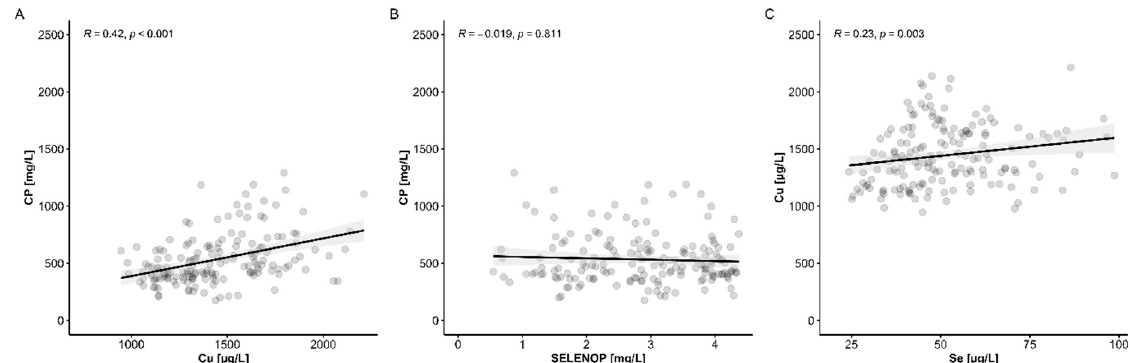
Figure 1. Analysis of serum Cu status in COVID-19 in relation to serum Se status. ( A ) The two biomarkers of Cu status, i.e., total Cu and CP concentrations showed a significant positive correlation in the full collection of serum samples. ( B ) In comparison, there was no interrelation of serum CP with SELENOP, whereas ( C ) serum Cu and Se showed a significant positive correlation with a marginal slope. R : Spearman correlation coefficient (2-sided, 2-tailed), p -values are indicated.